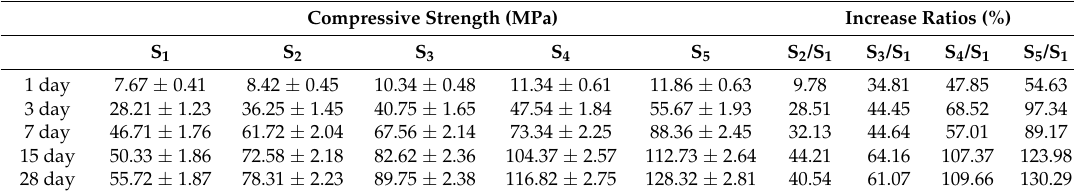
Table 3. Compressive strength of cement composites.